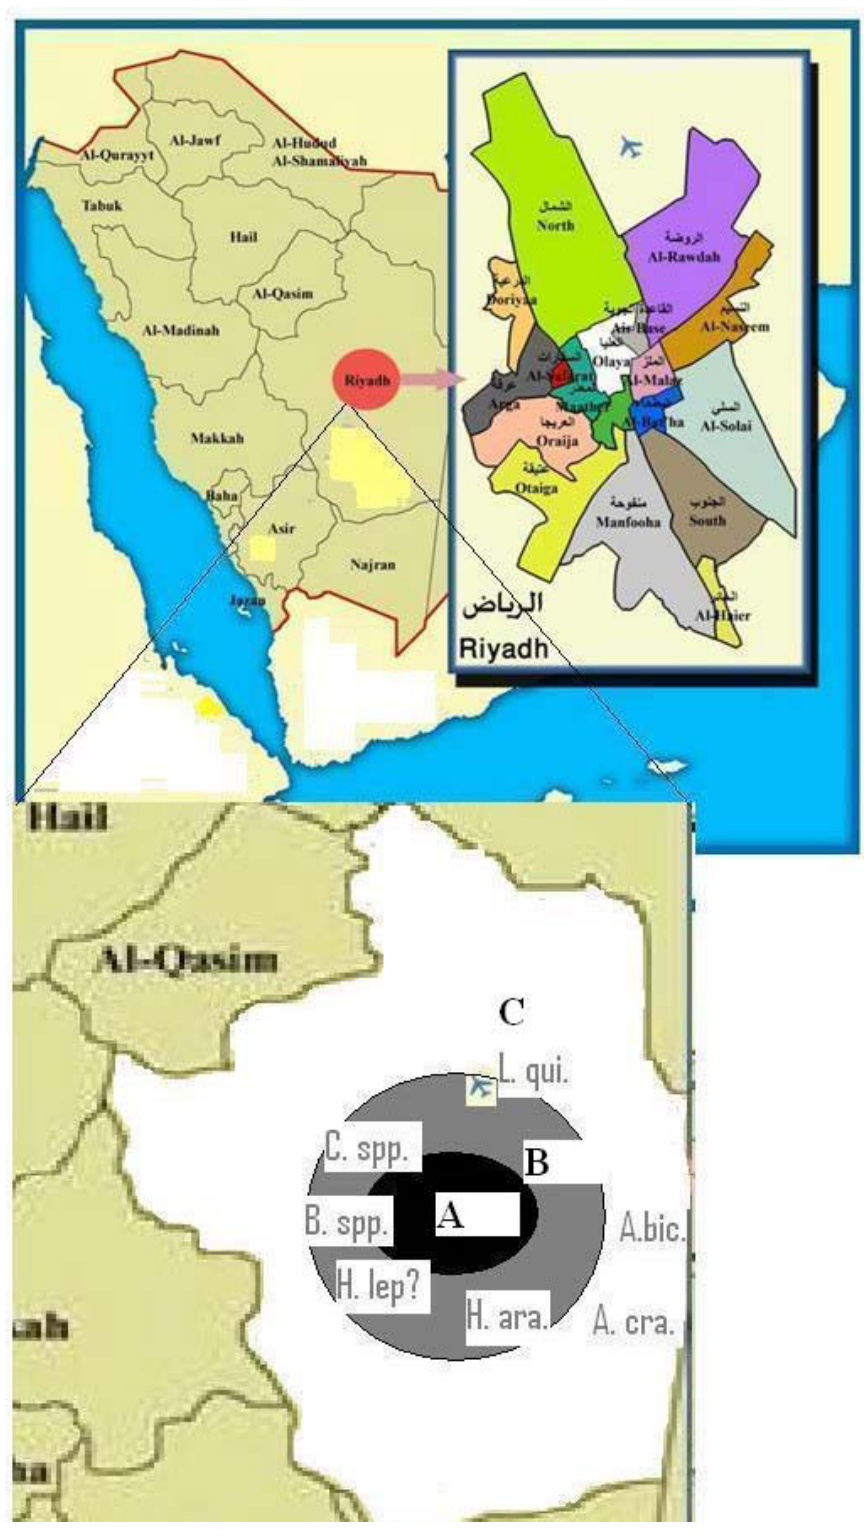
Figure 1. Map of the kingdom of Saudi Arabia, showing the distribution of scorpion species in the central